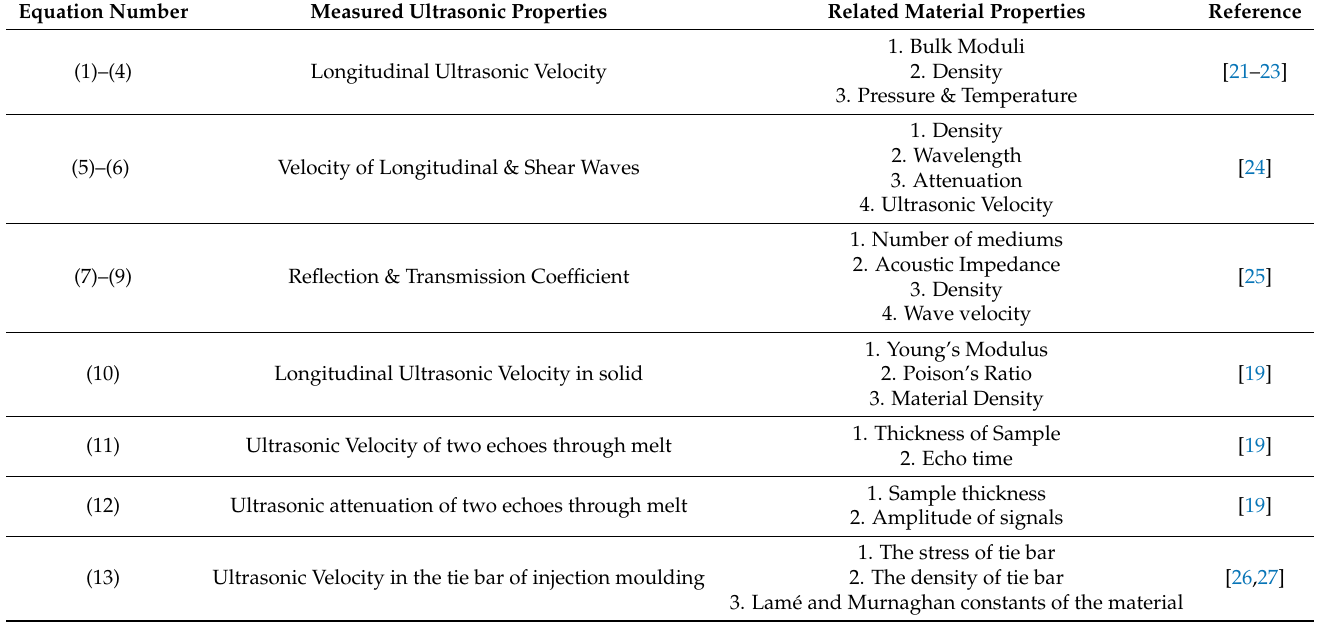
Table 1. Summary of Ultrasound propagation